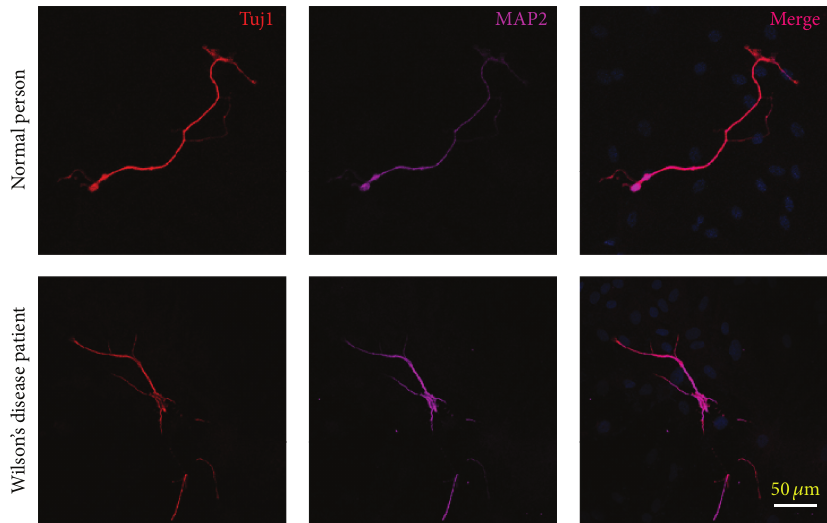
Figure 5: Urine cells from patients could be converted into neuron. Twelve days after doxycycline treatment, the urine from both normal individuals and WD patients could be converted into neurons as shown by the expression of Tuj1 and MAP2. Scale bars, 50 𝜇